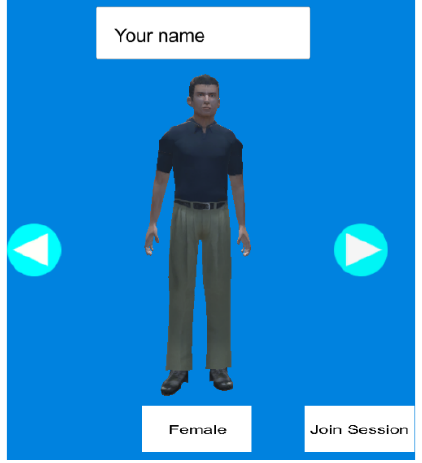
Figure 4: Selection of an avatar before joining a